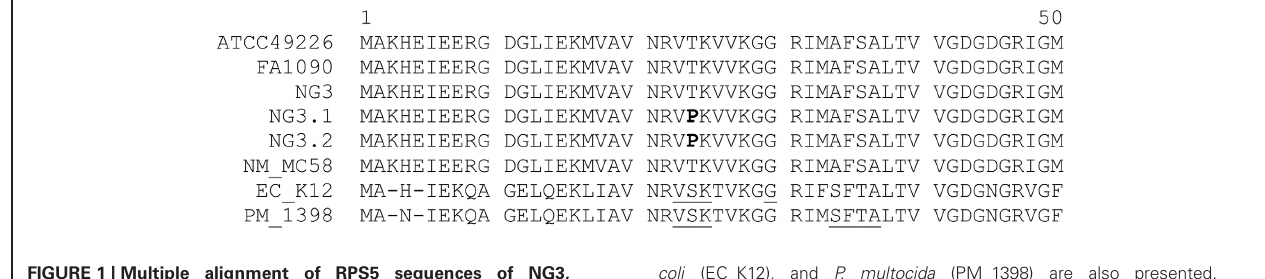
FIGURE 1 | Multiple alignment of RPS5 sequences of NG3, NG3.1, and NG3.2 strains. The Thr-24 → Pro mutation is bolded. Deduced amino acid sequences of RPS5 of wild-type N. gonorrhoeae (ATCC49226, FA1090), N. meningitidis (NM_MC58), E.